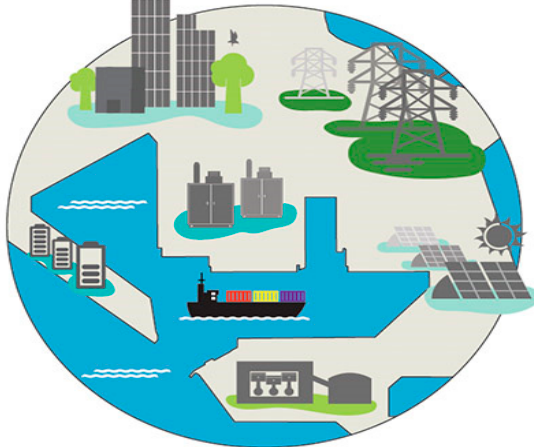
Figure 3. Future plan for Energy Island at POLB.